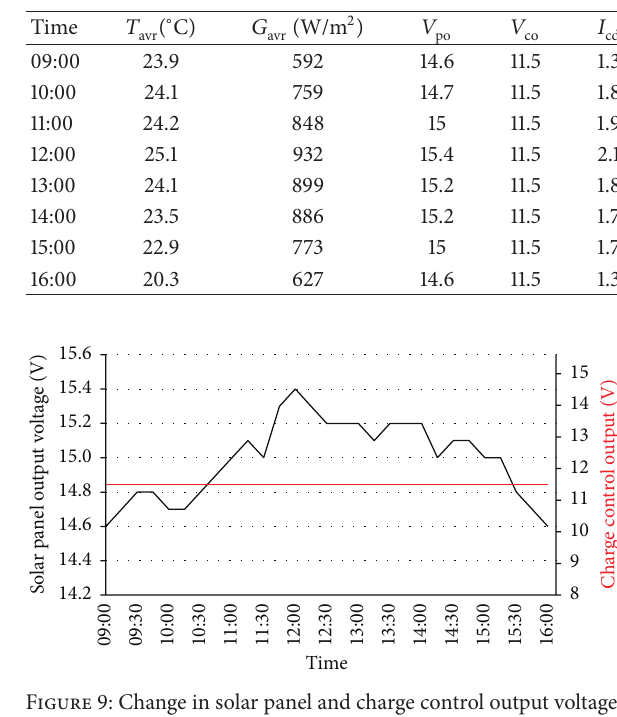
Table 4: Time related environment and panel data value.